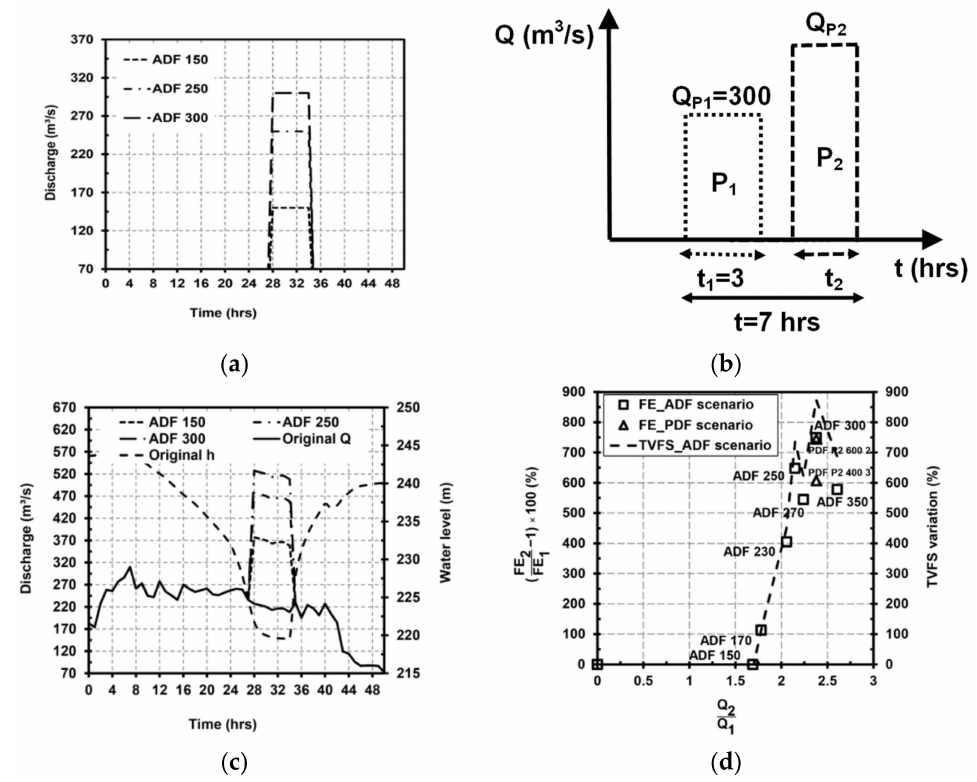
Figure 6. ( a ) Constant additional discharge rates used for different ADF scenarios (additional discharge pulse during the free-flow stage of the flushing operation) in the Unazuki Reservoir. These additional rates are added to the original discharge rates shown in Figure 1d. ( b ) Schematic figure illustrating the PDF scenario (pulses of discharge during the free-flow condition) with a variable discharge pulse (i.e., Q P2 ) in the second half of the free-flow stage. ( c ) Modified hydrodynamic boundary conditions for different ADF scenarios in the Unazuki Reservoir. ( d ) Non-dimensional curves showing the relationships among TVFS, FE (flushing efficiency), and the water discharge used under different ADF and PDF scenarios compared with the reference